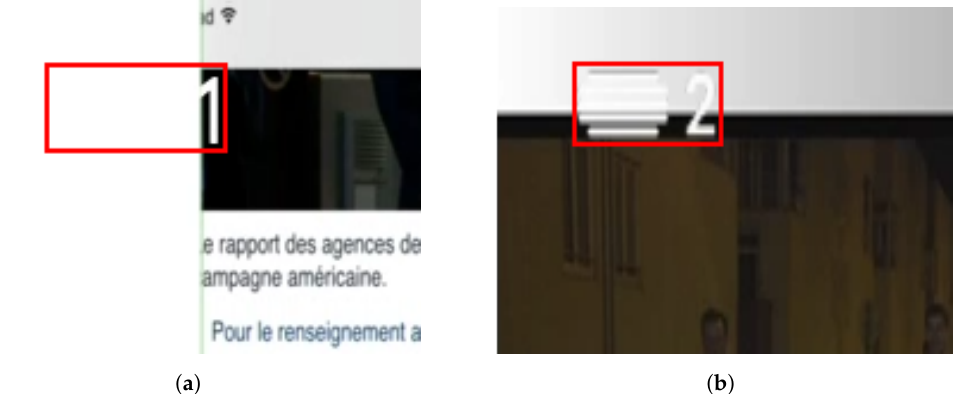
Figure 1. Example of a frame from RTP1a and RTP2 streams where the logo is only partially visible. In the left frame ( a ) the logo has only a small visible part and in the frame on the right ( b ) there is a larger visible portion, but blending with the background.